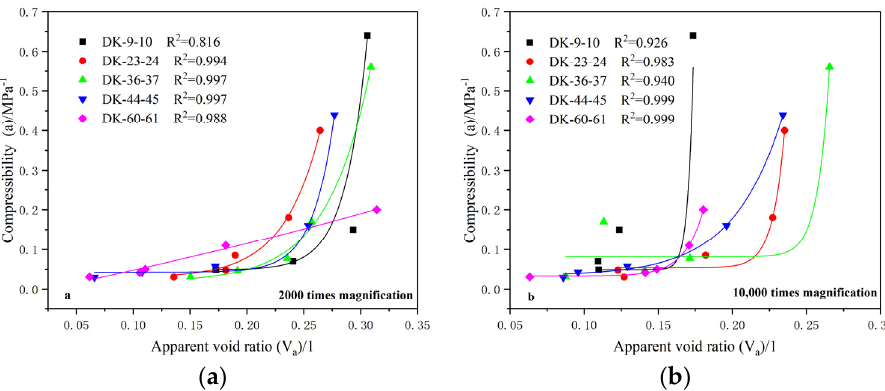
Figure 12. Relationship between the apparent void ratio and compressibility. ( a ) 2000 times magni- fication; ( b ) 10,000 times magnification. cation; ( b ) 10,000 times